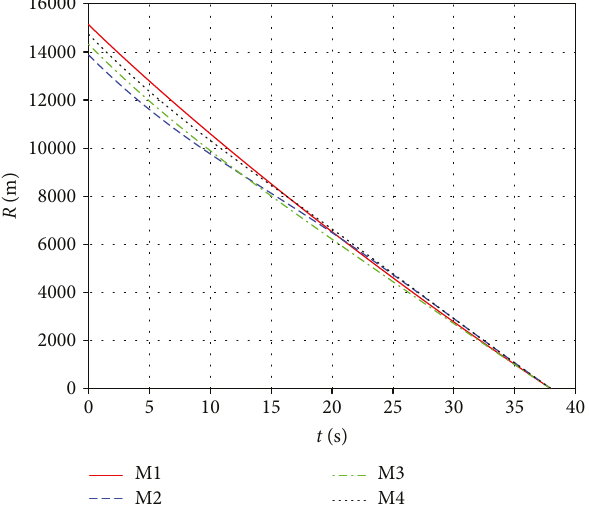
Figure 8: Relative distances between missiles and the target with impact time control.